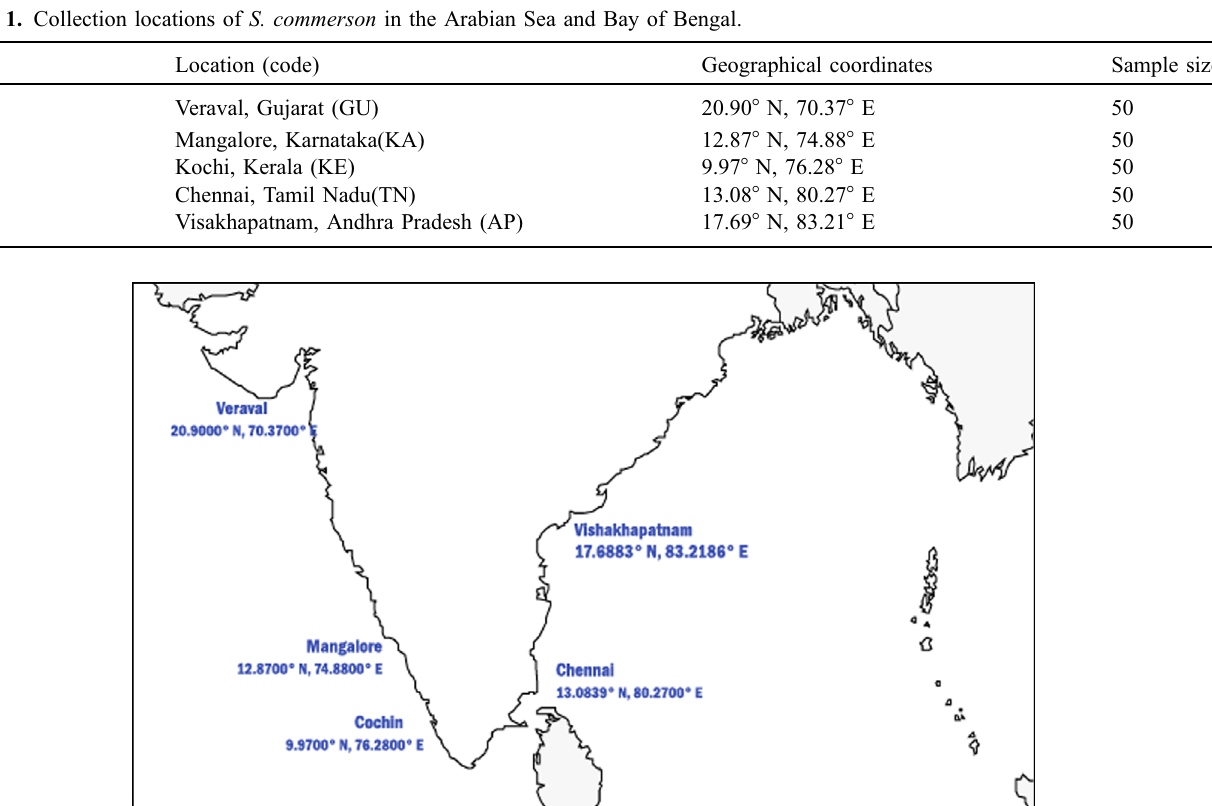
Fig. 1. Map depicting the sampling location of S. commerson.